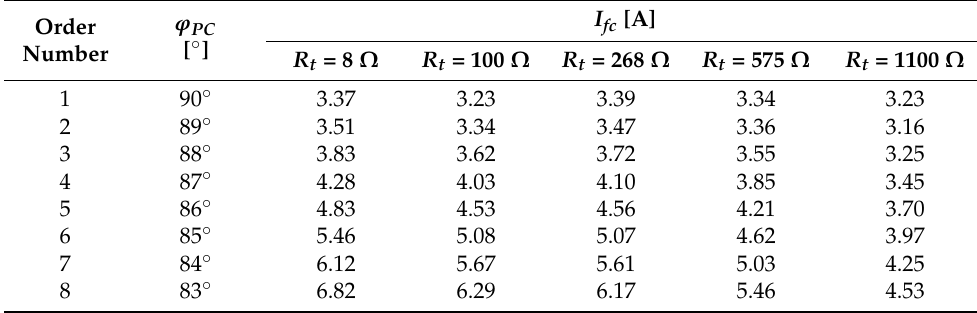
Table 10. Effective value of the fault current depending on ϕ PC , when ϕ c = 90 ◦ .